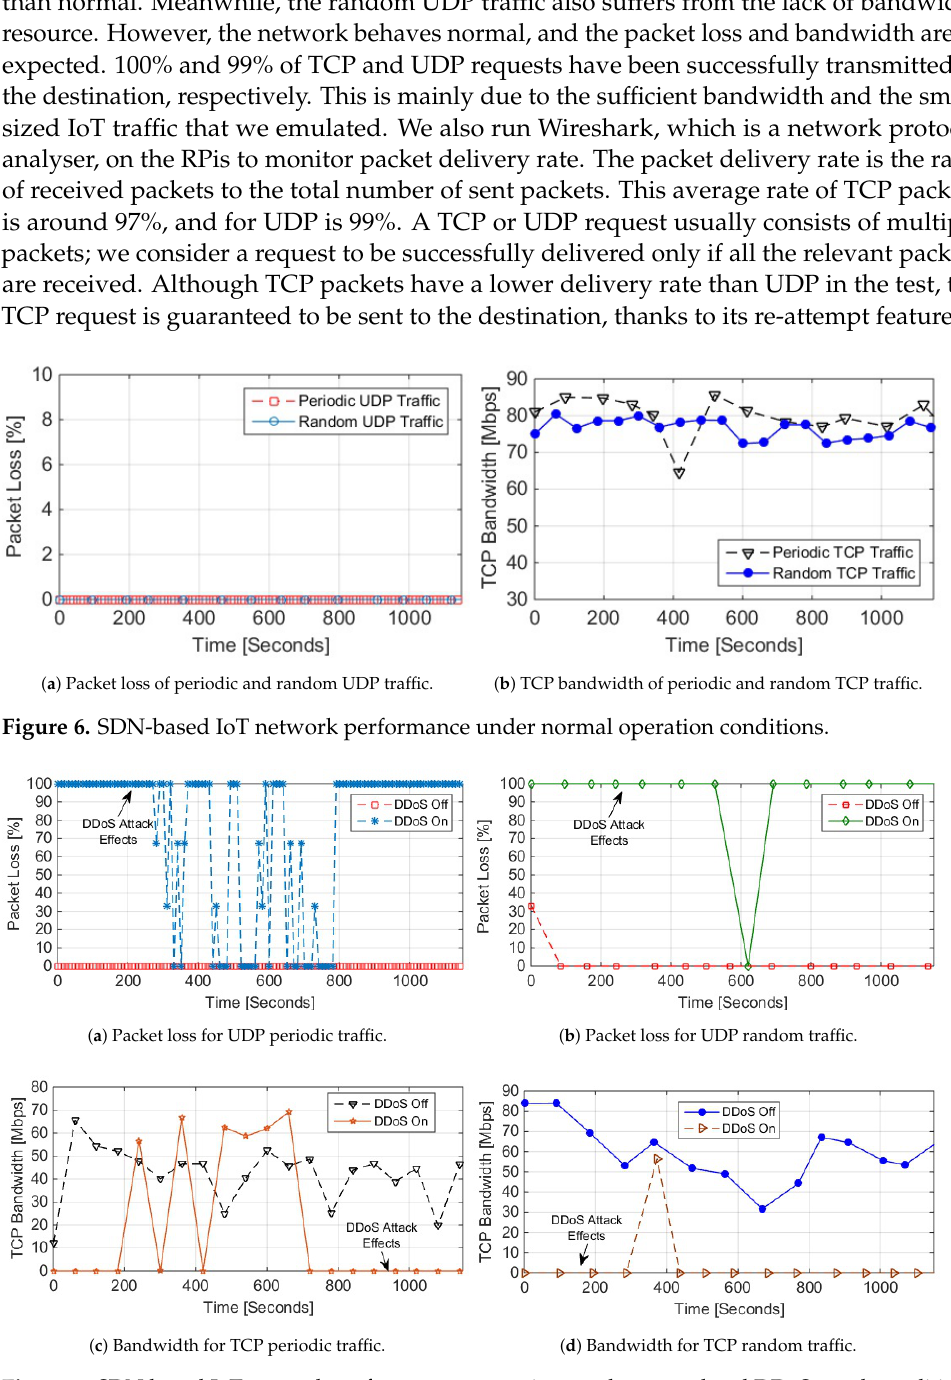
Figure 7. SDN-based IoT network performance comparison under normal and DDoS attack